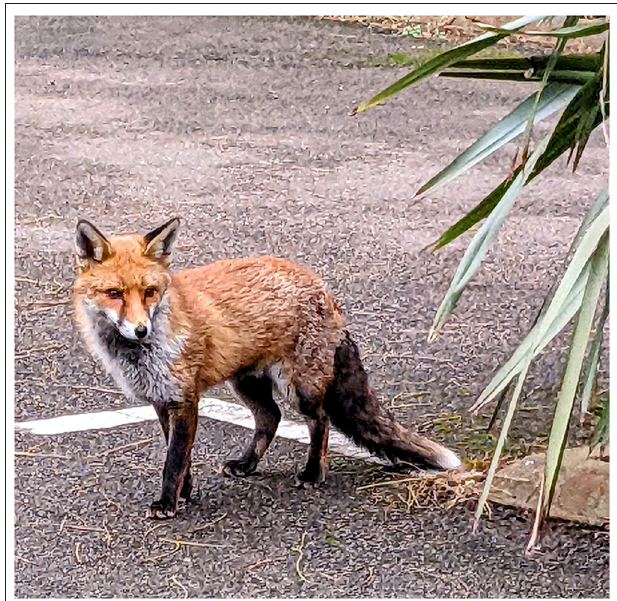
FIGURE 10 | Urban fox in Battersea,